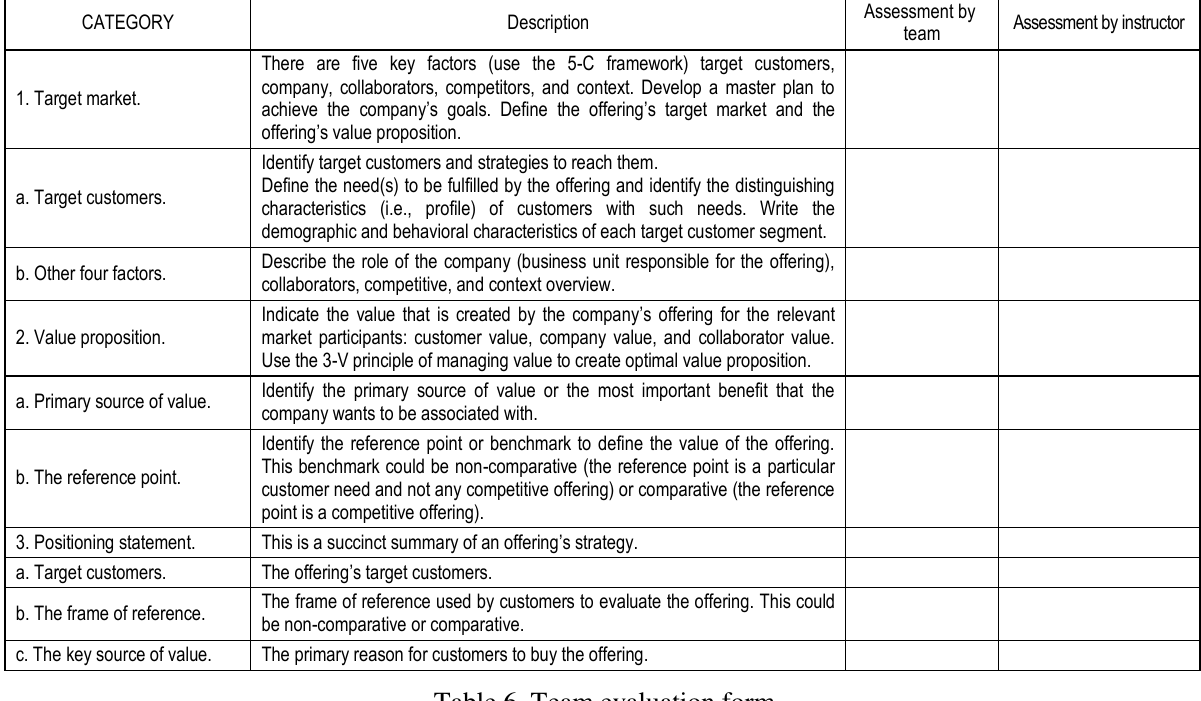
Table 6. Team evaluation